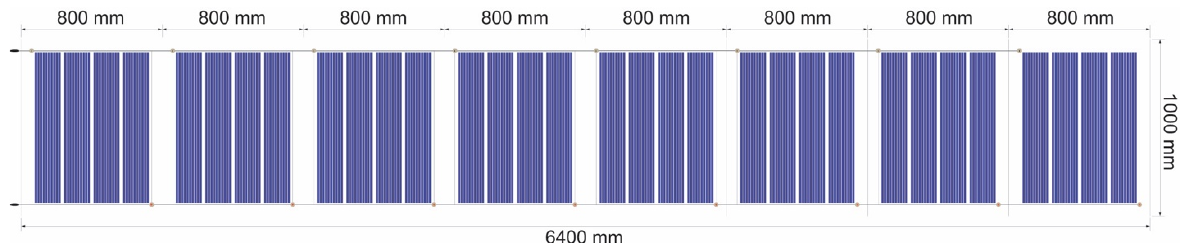
Figure 2. OPV array architecture. Eight parallel-connected OPV panels, with four serially connected module strings per panel, 10 cells per module. Electrical leads are located at the end (left on the image) of the OPV roll. Table 1. OPV array technical specifications (provided by the manufacturer).